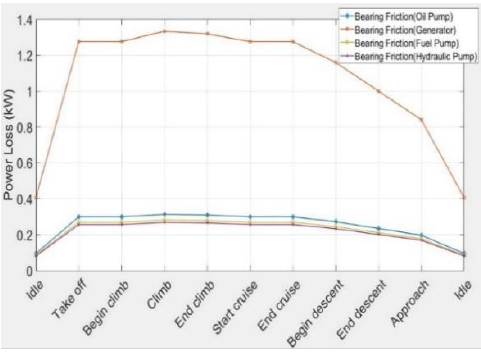
Figure 4. Power losses due to bearing friction.